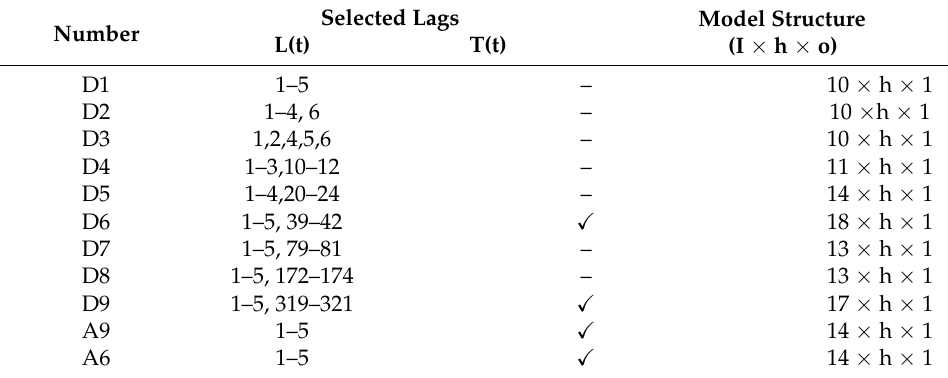
Table 3. Selected lags and proposed WANN model